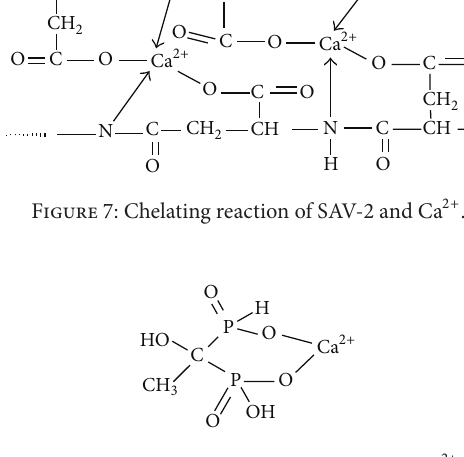
Figure 8: Chelating reaction of SAV-1 and Ca 2+ .